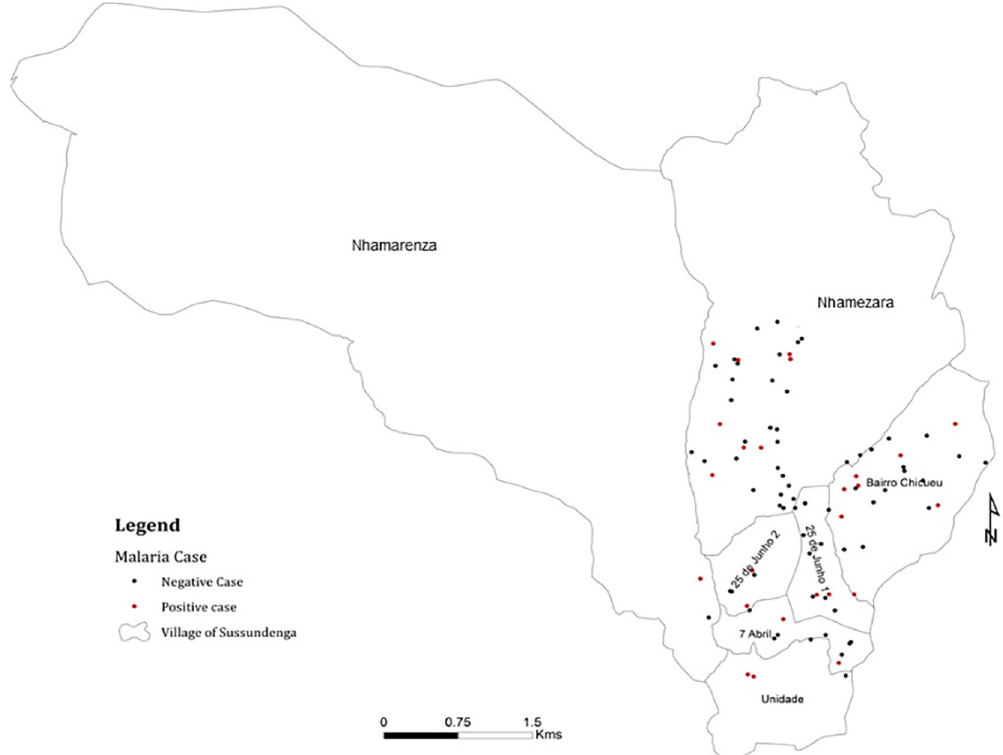
Figure 3. Malaria positive and negative cases in Sussundenga village.